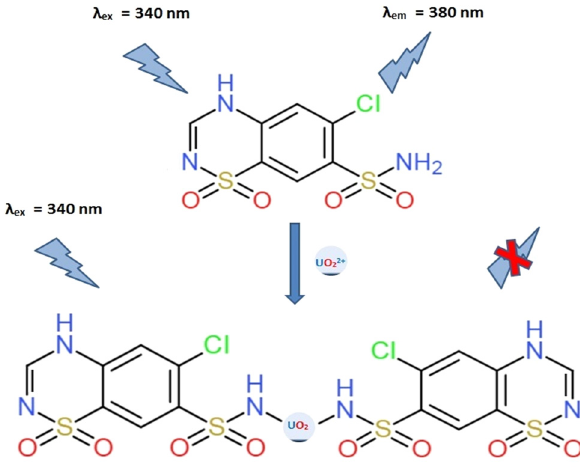
Scheme 1: A schematic representation of the proposed quenching mechanism of the L sensor with UO 2 2 + .